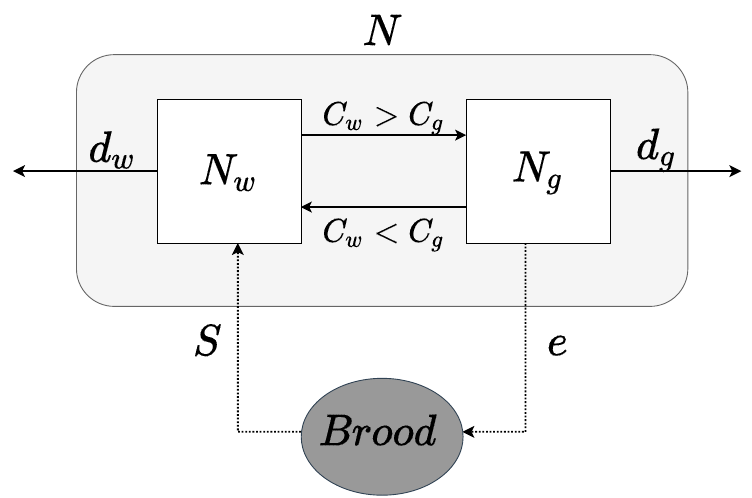
Figure 1. Schematic flow diagram for our